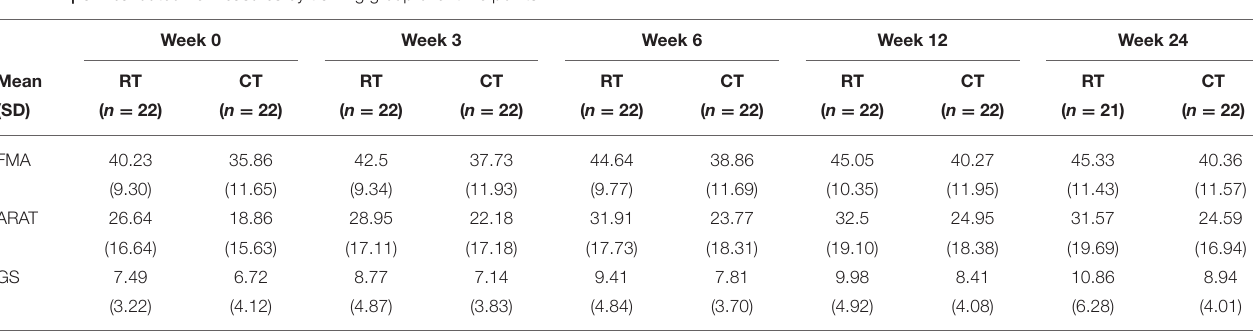
TABLE 2 | Clinical outcome measures by training group over time